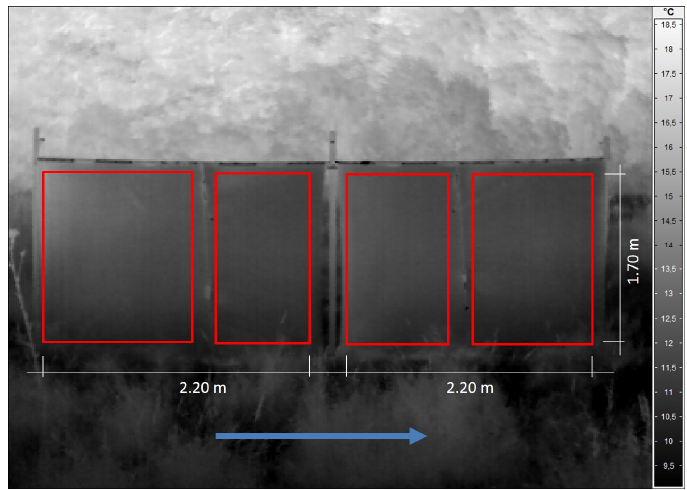
Figure 2. TIR image of the PS. Blue arrow = cold-air flow direction; red boxes = usable TIR data at the PS, starting at 20 cm above ground; parts outside the red boxes: air temperature sensor locations and PS installation elements.